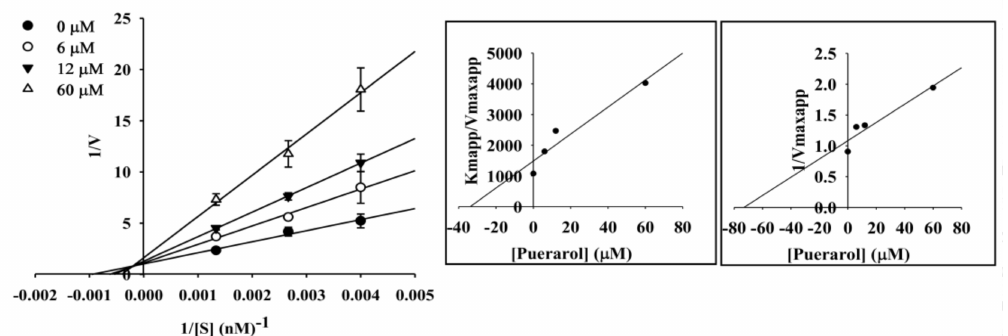
Figure 4. Lineweaver-Burk plots and secondary plots for BACE1 inhibition of